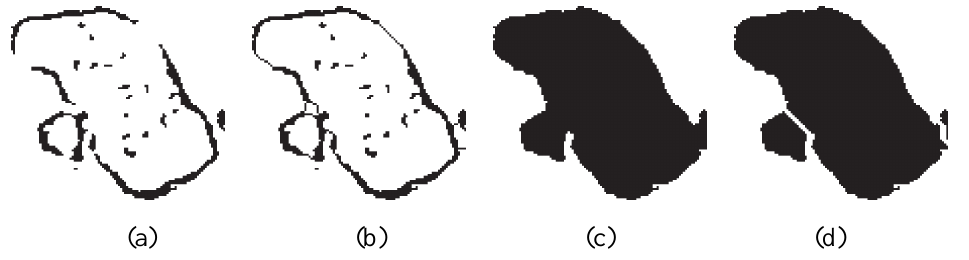
Fig. 3. The process from threshold to separated